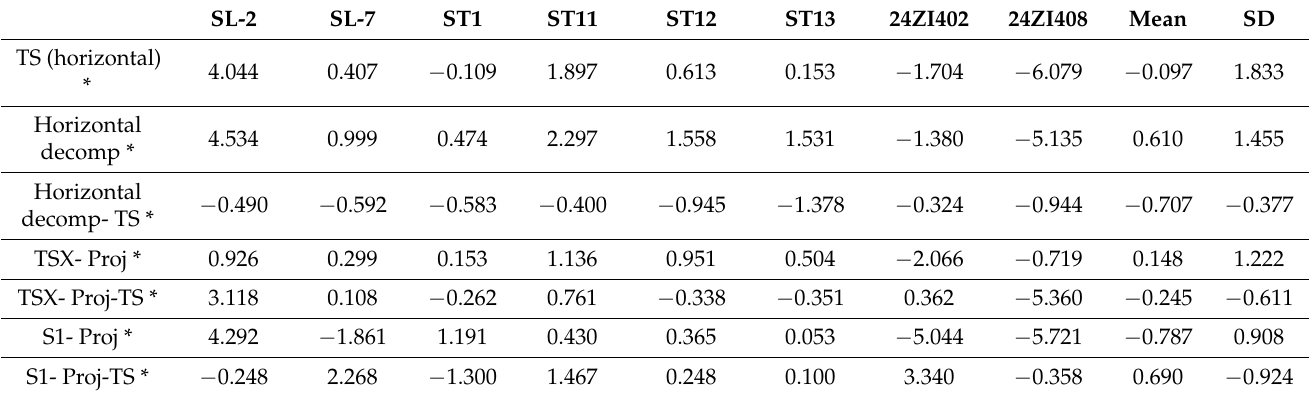
Table 4. Comparison of values of horizontal displacement.